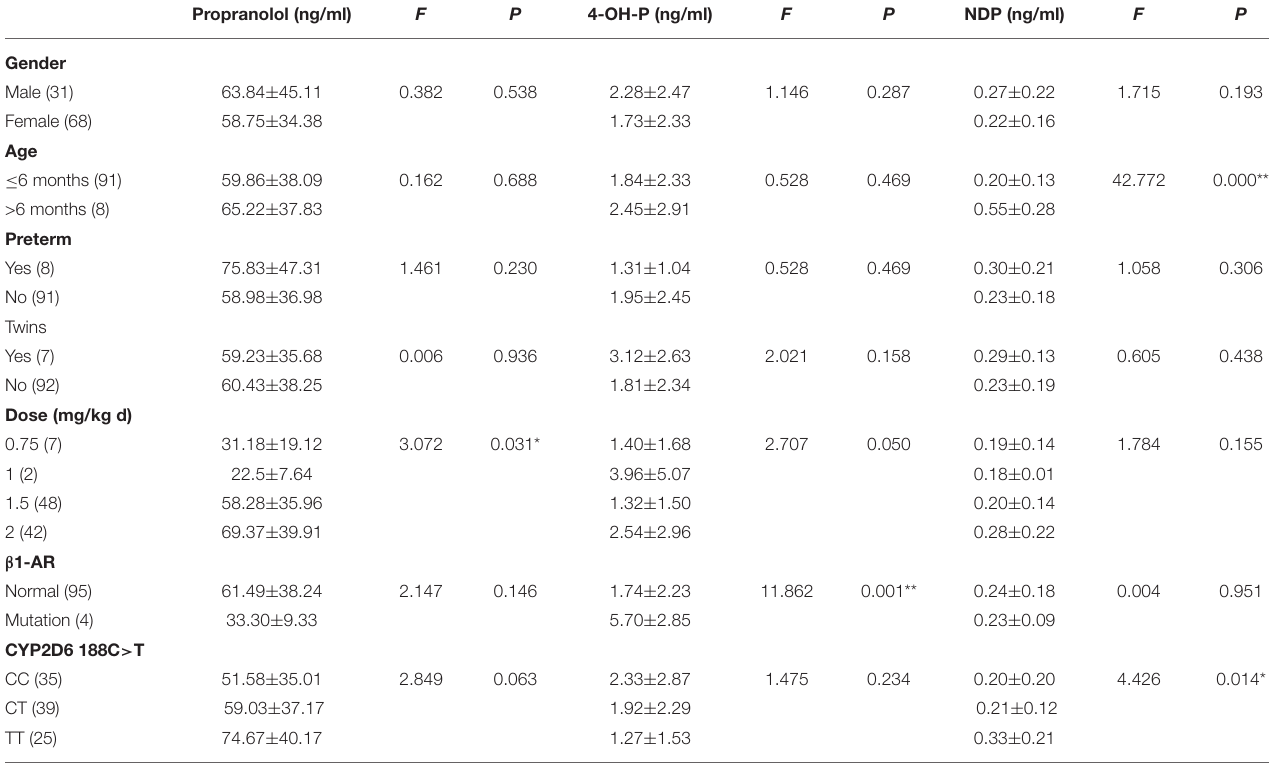
TABLE 1 | The factors affecting the drug blood concentration in the peak concentration group. Propranolol (ng/ml) F P 4-OH-P (ng/ml)